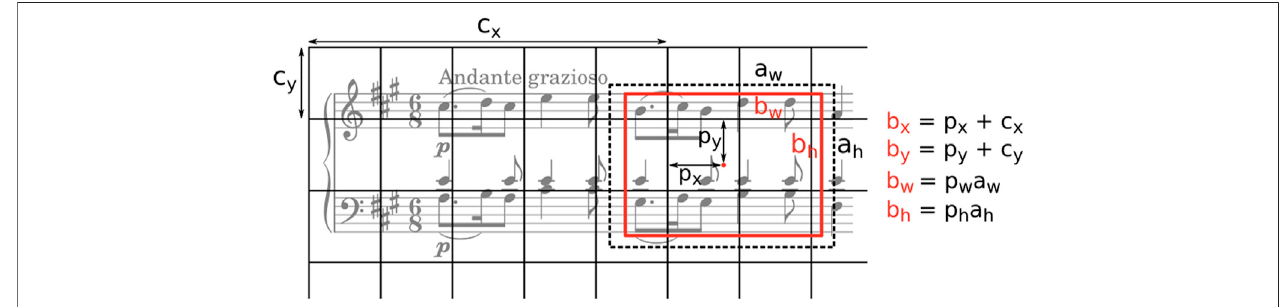
FIGURE5| Anchor-basedboundingboxprediction.Thenetworkpredictsrelativeboxcoordinates( p x , p y )foreachgridcell(offsetfromthetopleftcorner by c x , c y ) as well as width and height values ( p w , p h ) to scale the anchor ( a w , a h ) (visualized as a dashed rectangle). The resulting bounding box is depicted in red. For the computation of p x , p y , p w , p h see Eq. 2 . Figure inspired by (Redmon and Farhadi,